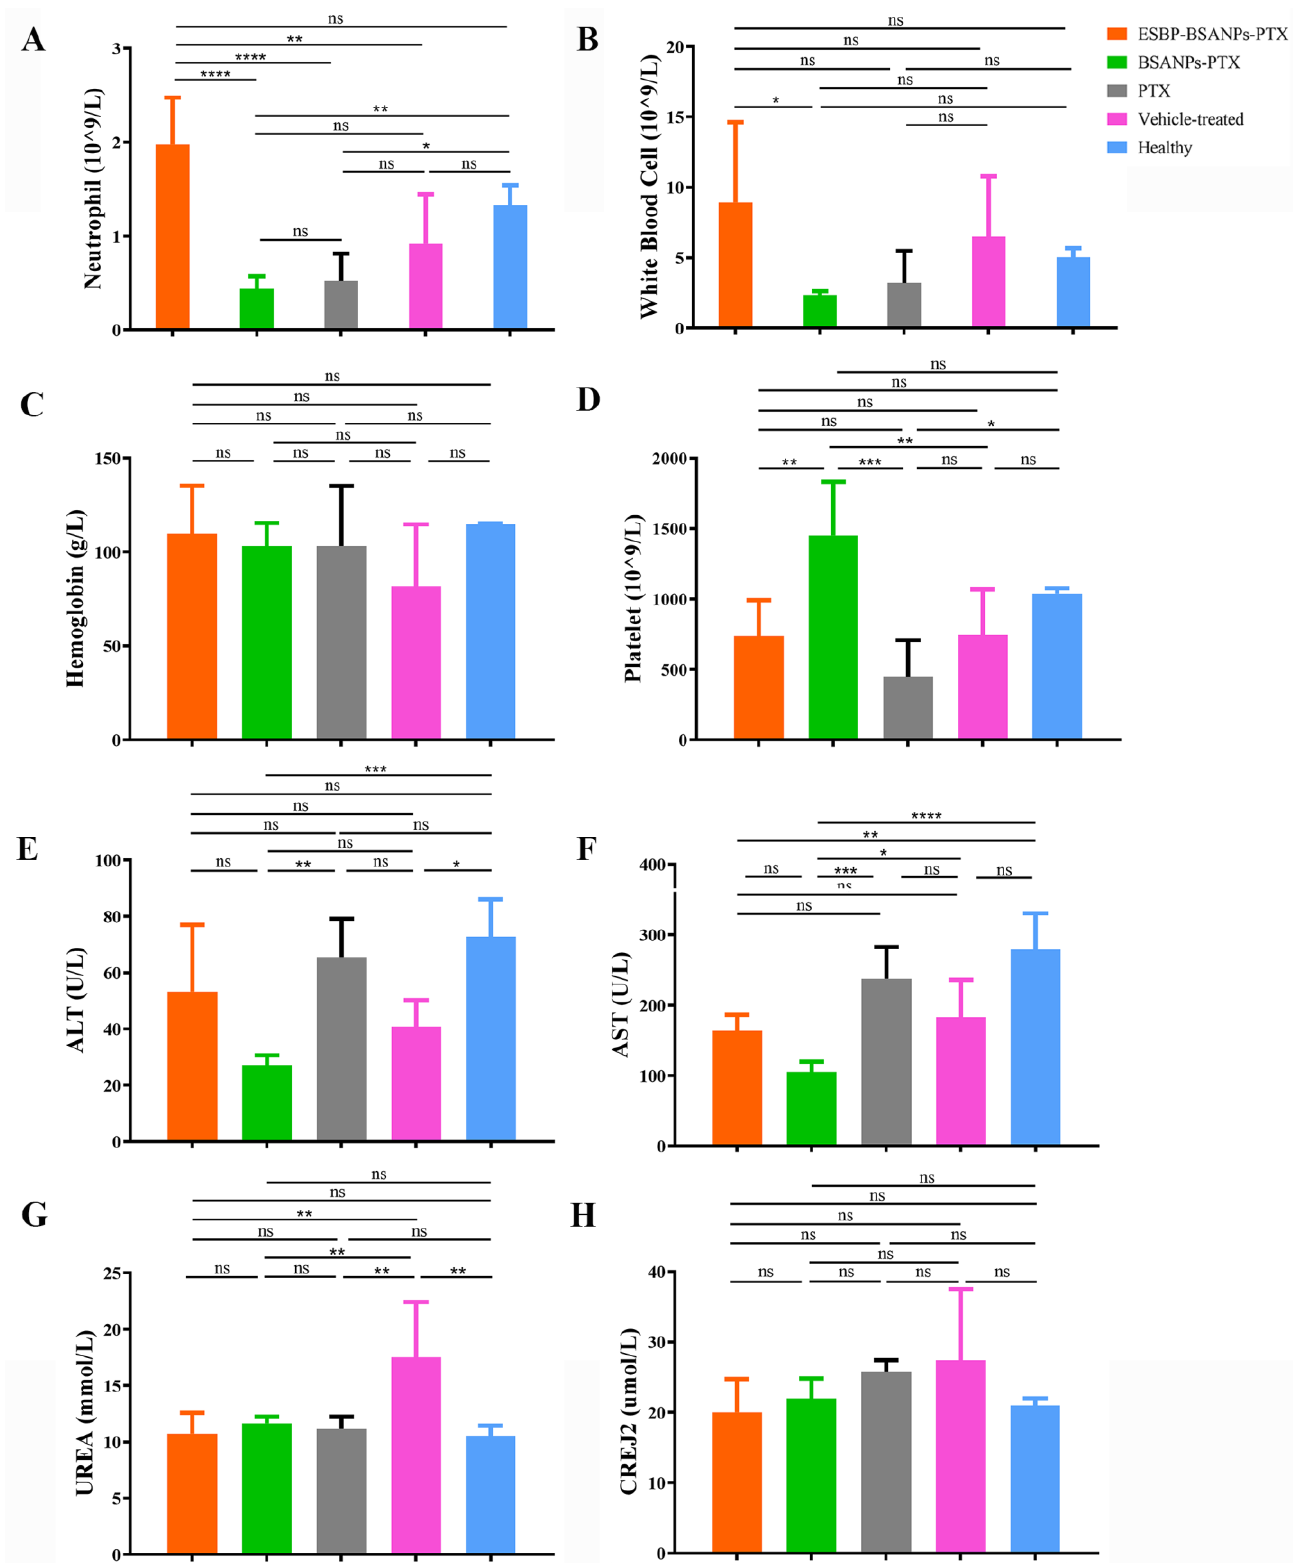
Figure 6. Blood test results after four cycles of treatment: ( A ) neutrophil number (Gran#), ( B ) white blood cell (WBC), ( C ) hemoglobin (HGB), ( D ) platelets (PLT), ( E ) alanine aminotransferase (ALT), ( F ) aspartate aminotransferase (AST), ( G ) urea (UREA) and ( H ) creatinine (CREJ2) (mean ± SD, n = 5). ns represents p > 0.05; * p < 0.05, ** p < 0.01, *** p < 0.001 and **** p < 0.0001.